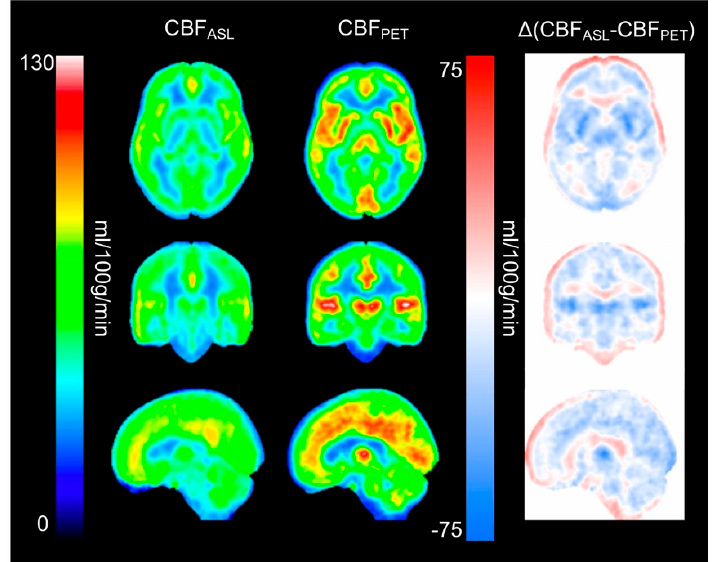
Figure 1. Average parametric CBF ASL and CBF PET images, and differences (CBF ASL –CBF PET ) in MNI template space. Normalization performed with SPM12. Table 1. Descriptive statistics of CBF PET and CBF ASL with correlation and slope from the correlation analysis including orthogonal regression.